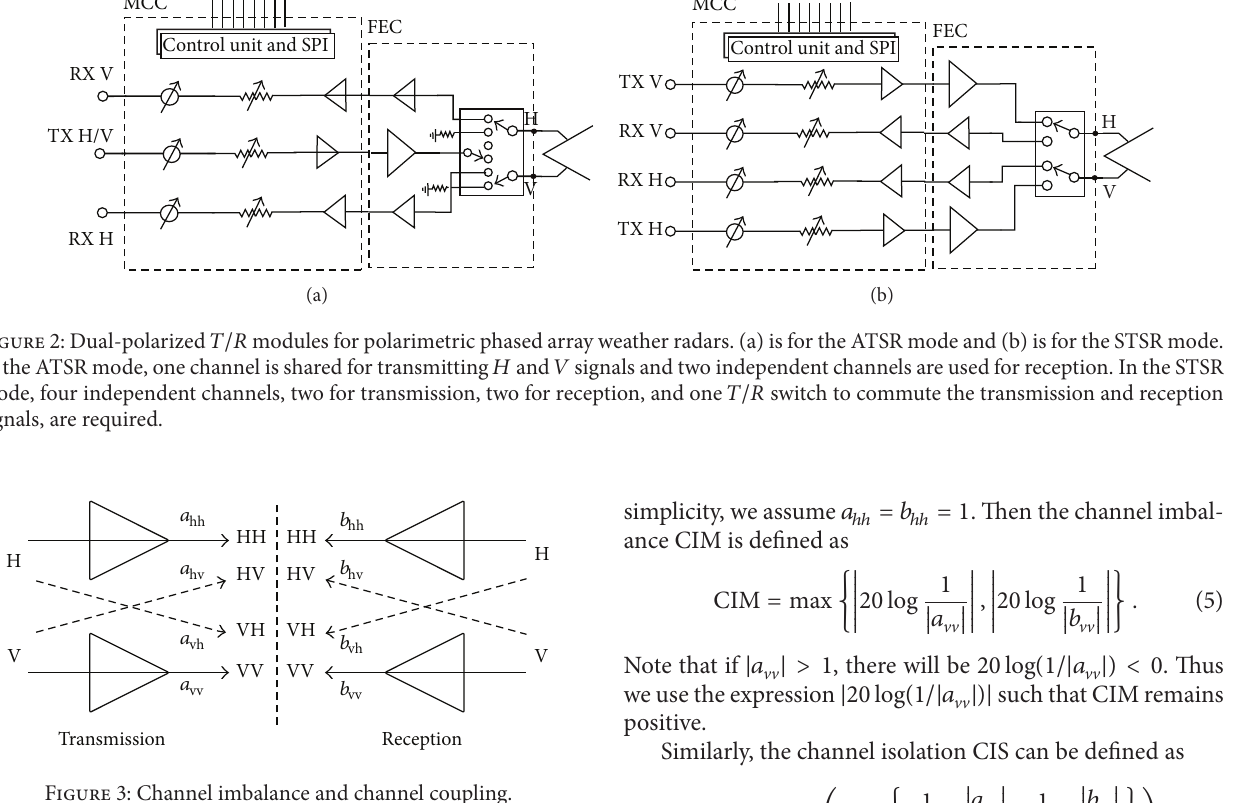
Figure 3: Channel imbalance and channel